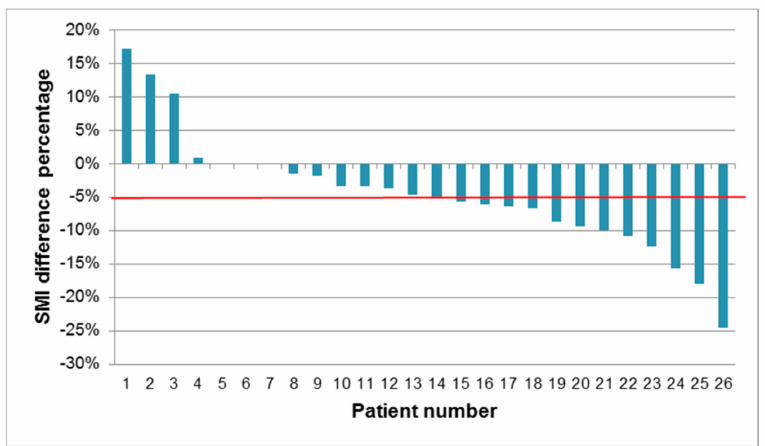
Figure 2. Waterfall plot demonstrating percent change in SMI between pre- and post-FLOT chemotherapy. Each bar represents one patient. The horizontal red line indicates the median % change in SMI ( −